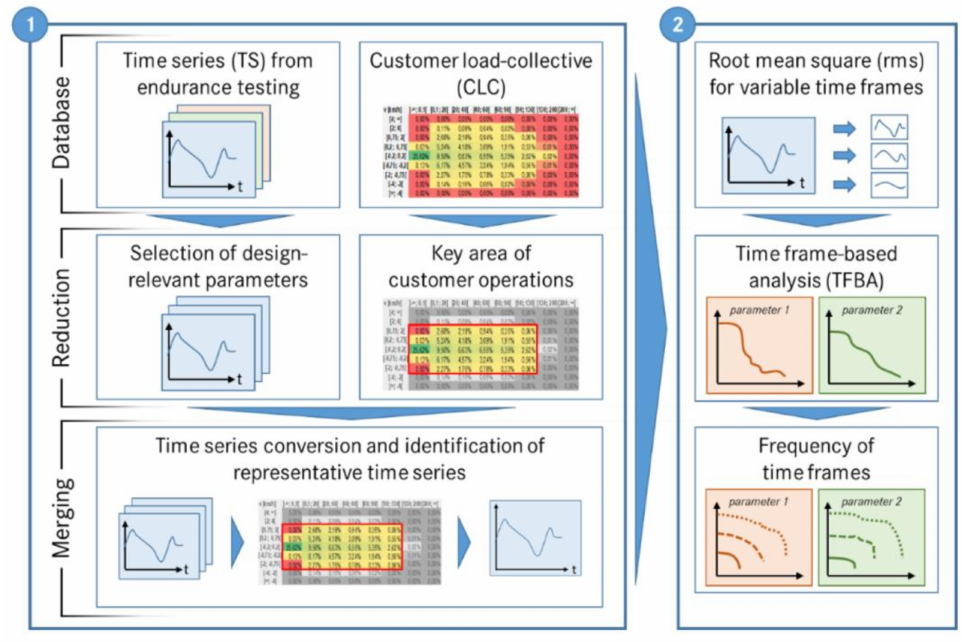
Figure 1. Scheme of the methodological